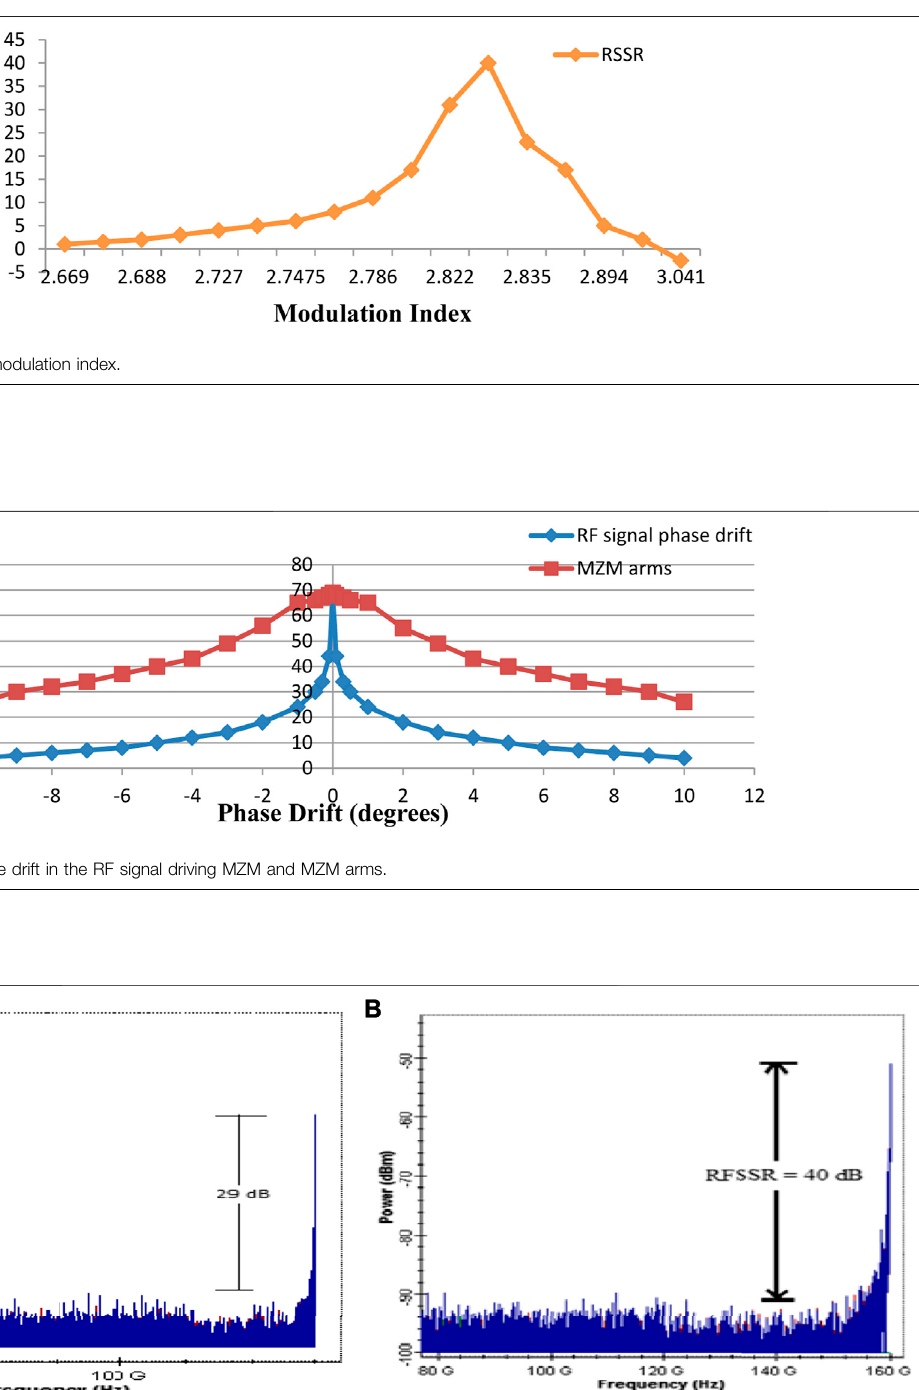
20-dB gain and NF of 4 dB when detected by the PIN photodiode generates a 160-GHz with a 29-dB RFSSR, as shown in Figure 12 . It can be noted that the cascaded ampli fi er con fi guration results in the improved RFSSR.